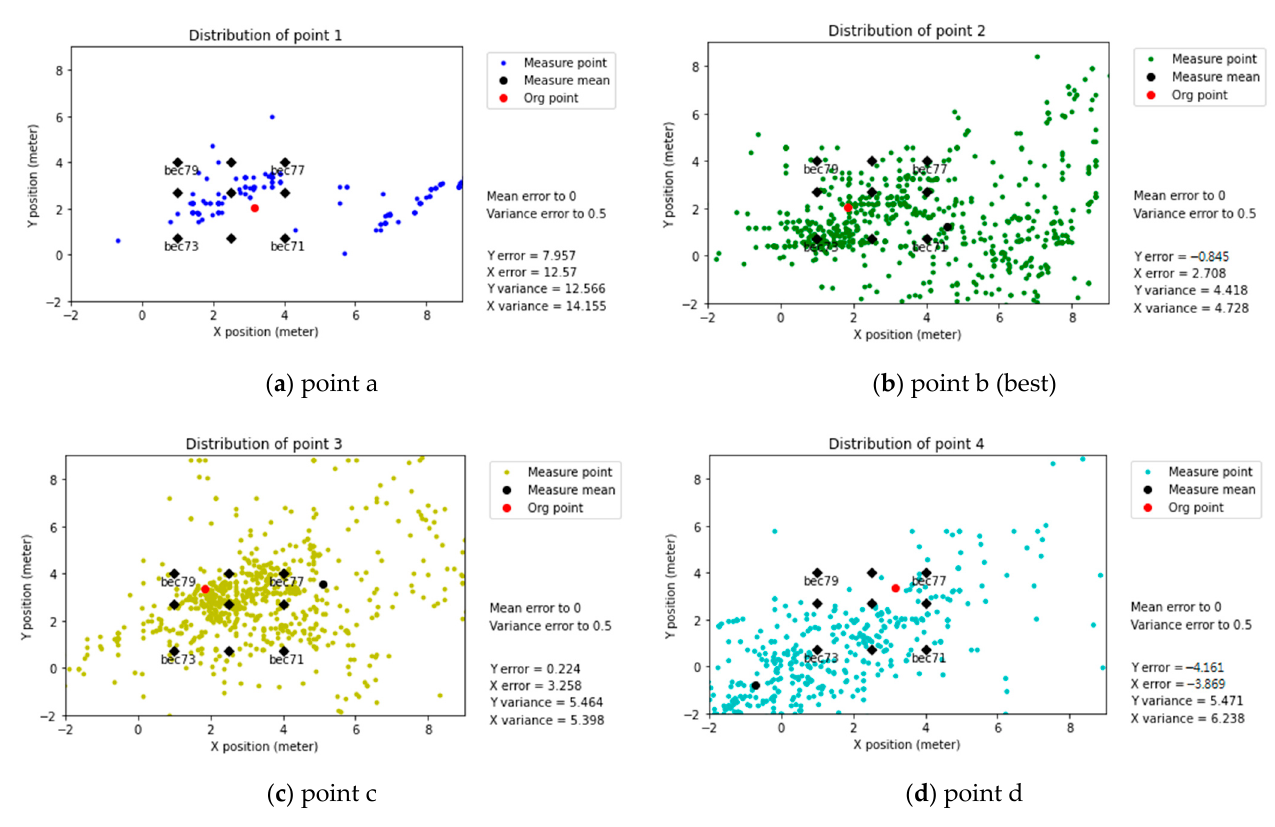
Figure 17. Predicted positioning (without modification coefficients), BLE 5.0 (Nano 33).